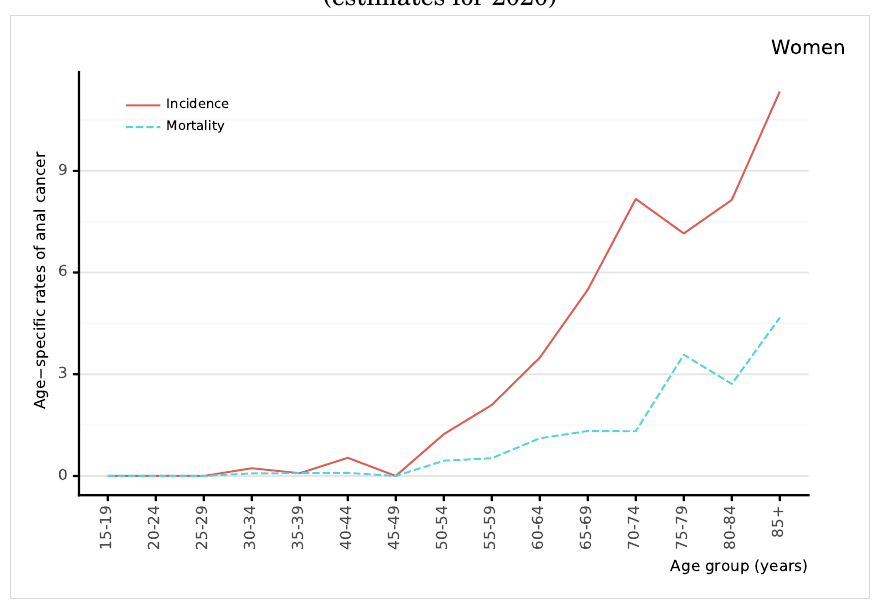
Figure 20: Comparison of age-specific anal cancer incidence and mortality rates among women in